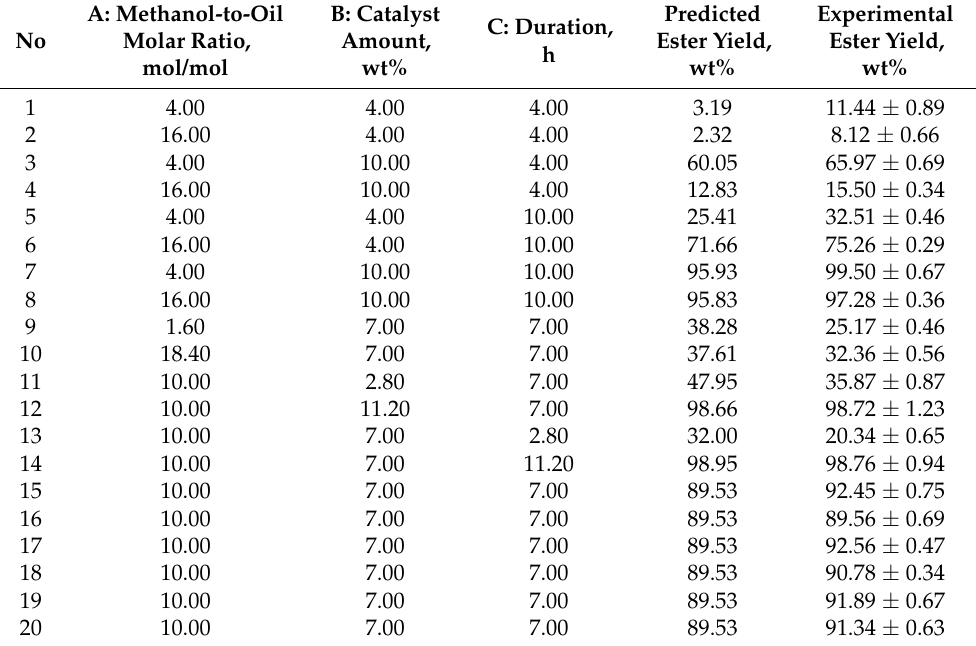
Table 1. Experimental plan, predicted and experimental ester yield depending on independent